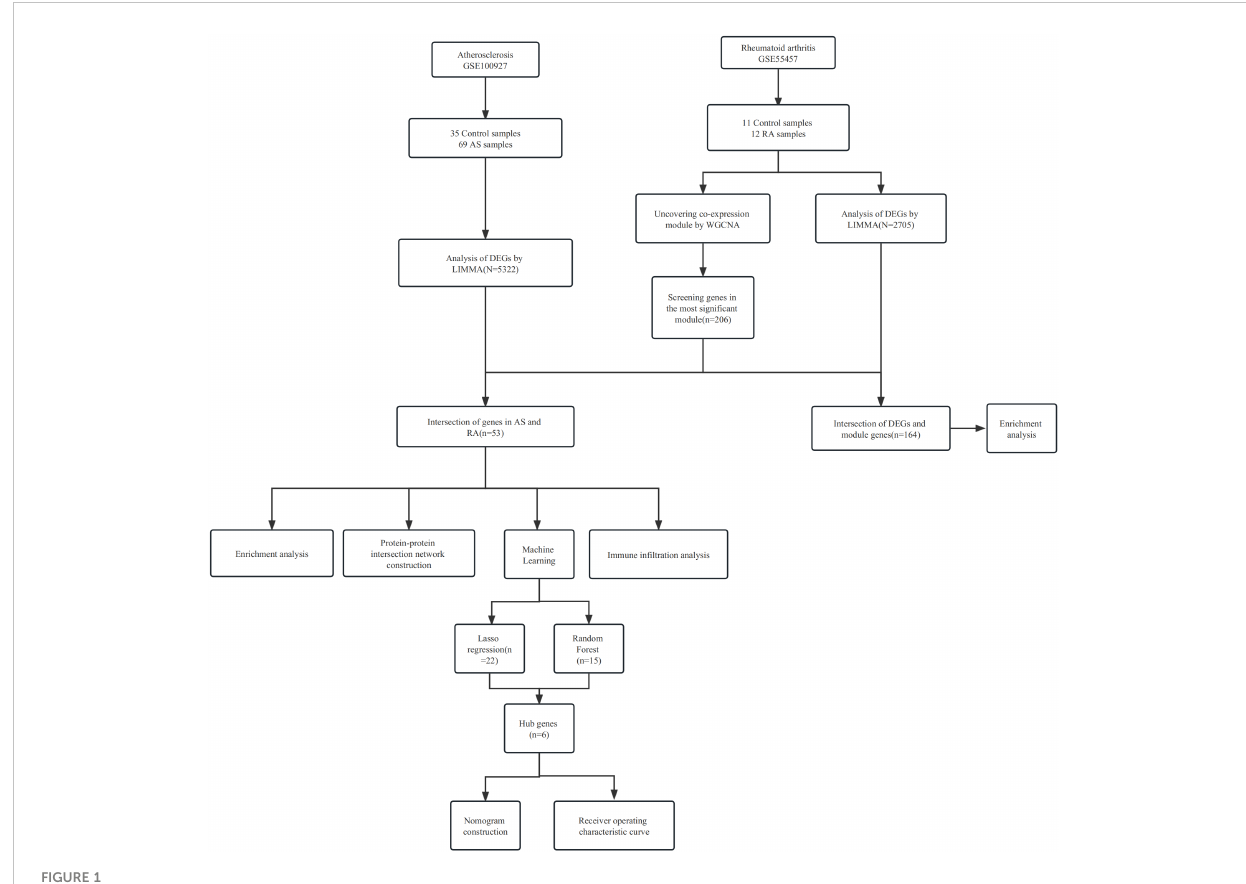
FIGURE 1 Work fl ow of the